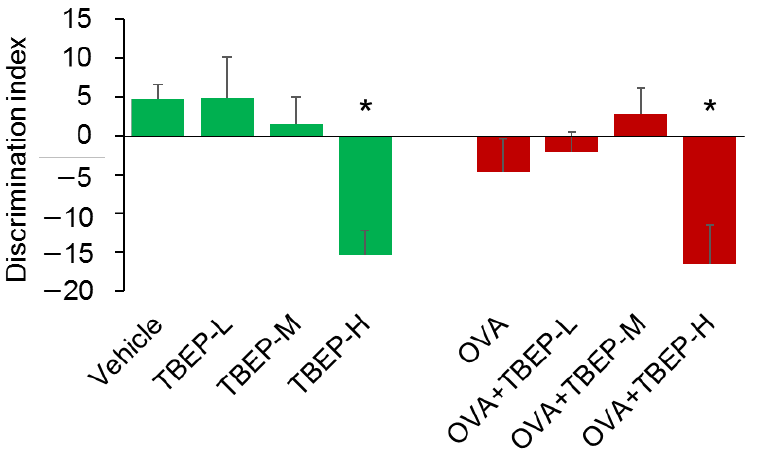
Figure 2. Novel object recognition test. Discrimination index between familial and novel objects was measured (n = 6, * p < 0.05 vs. vehicle group).